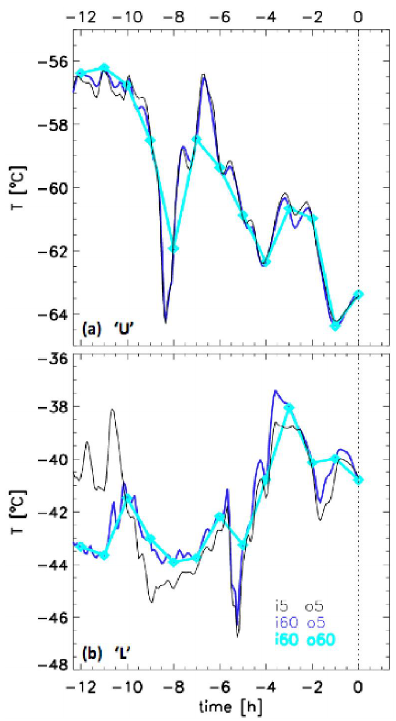
Figure C1. Examples of backward trajectories for (a) the upper cloud ‘U’, (b) lower cloud 2 Fig. C1. Examples of backward trajectories for (a) the upper cloud “U”, (b) lower cloud “L”. Black curves: based on COSMO-7 fields ‘L’. Black curves: based on COSMO-7 fields with 5-minute resolution, providing trajectory 3 with 5-min resolution, providing trajectory values every 5min. Dark blue curves: based on COSMO-7 fields with 1-h resolution, in- values every 5 minutes. Dark blue curves: based on COSMO-7 fields with 1-hour resolution, 4 terpolating trajectory values every 5min. Cyan curves: based on interpolating trajectory values every 5 minutes. Cyan curves: based on COSMO-7 fields with 5 COSMO-7 fields with 1-hour resolution, providing trajectory val- ues every 1-hour resolution, providing trajectory values every 1 hour. 6